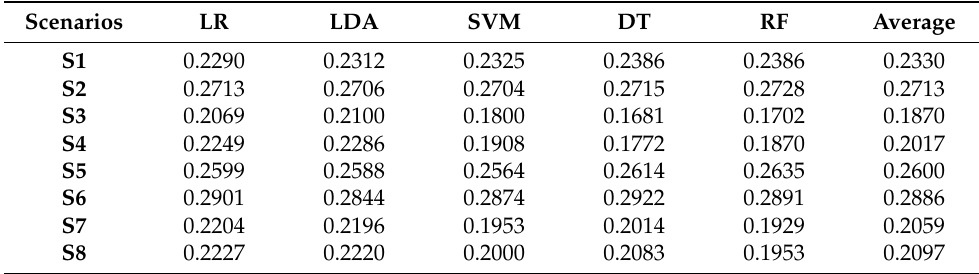
Table 4. Medians of MSPE for the eight scenarios and different classifiers and average values of all different classifiers. Scenarios